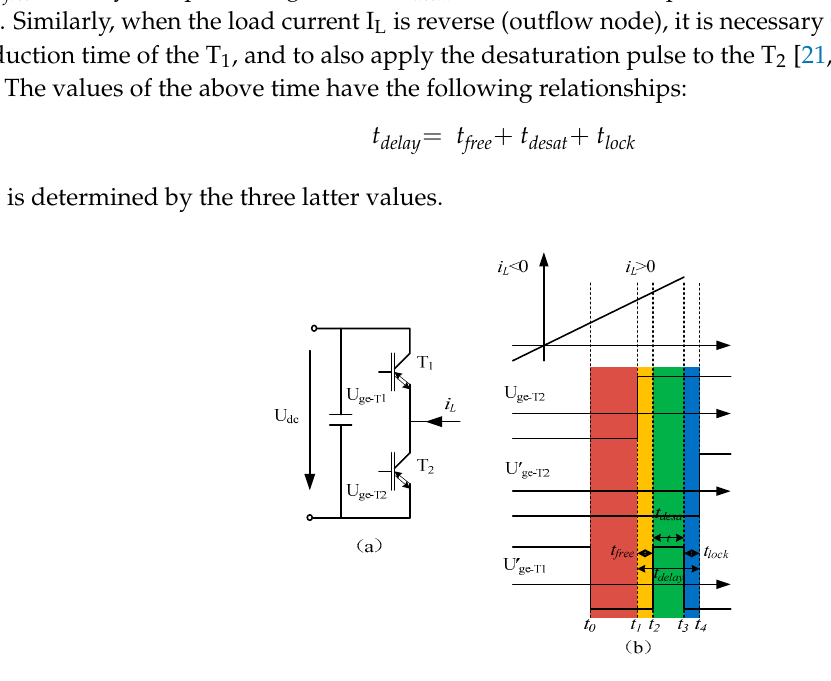
Figure 3. Desaturation pulse control of RC-IGBT in half bridge: ( a ) The structure of RC-IGBT in half bridge; ( b ) The logic of desaturation pulse control.